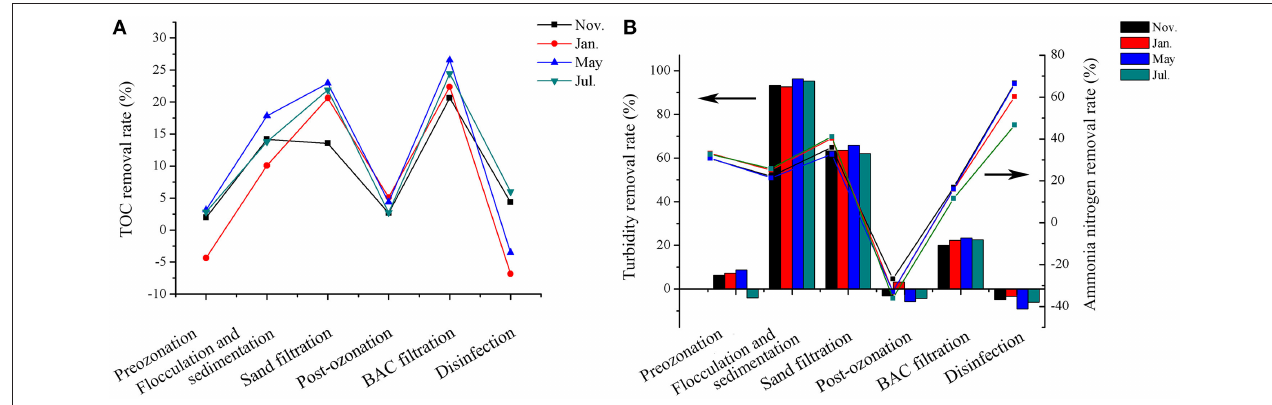
FIGURE 2 | Variations in removal rates of TOC (A) , turbidity (left axes, histogram) and ammonia nitrogen (right axes, line graph) (B) along the treatment processes at different times. The arrows in the figure indicated the corresponding vertical coordinate of different